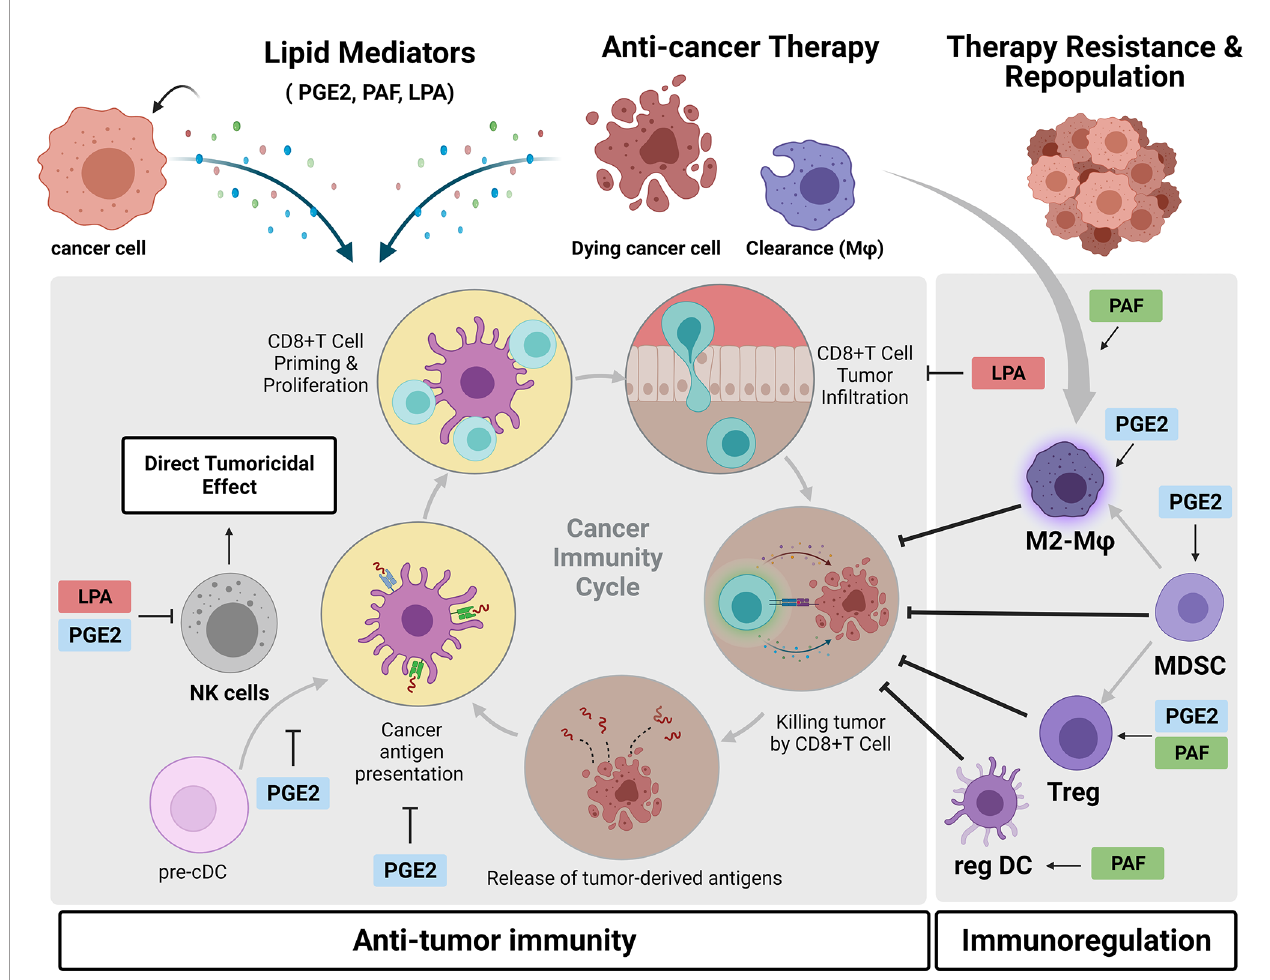
FIGURE 5 | Crosstalk between cancer cells and the immune microenvironment mediated by phosphatidylcholine (PtdCho)-derived lipid mediators. During tumor progression and in response to anticancer treatments, cancer cells generate PtdCho-derived lipid mediators, such as prostaglandin E2 (PGE2), platelet-activating factor (PAF), and LPA. Once released in the tumor microenvironment, they bind to their cognate receptors present in diverse immune cells, inhibiting the antitumor immunity and promoting immunoregulation. These lipid mediators exert a complex interplay between tumor and immune cells that contributes to therapy resistance and tumor repopulation. Created with